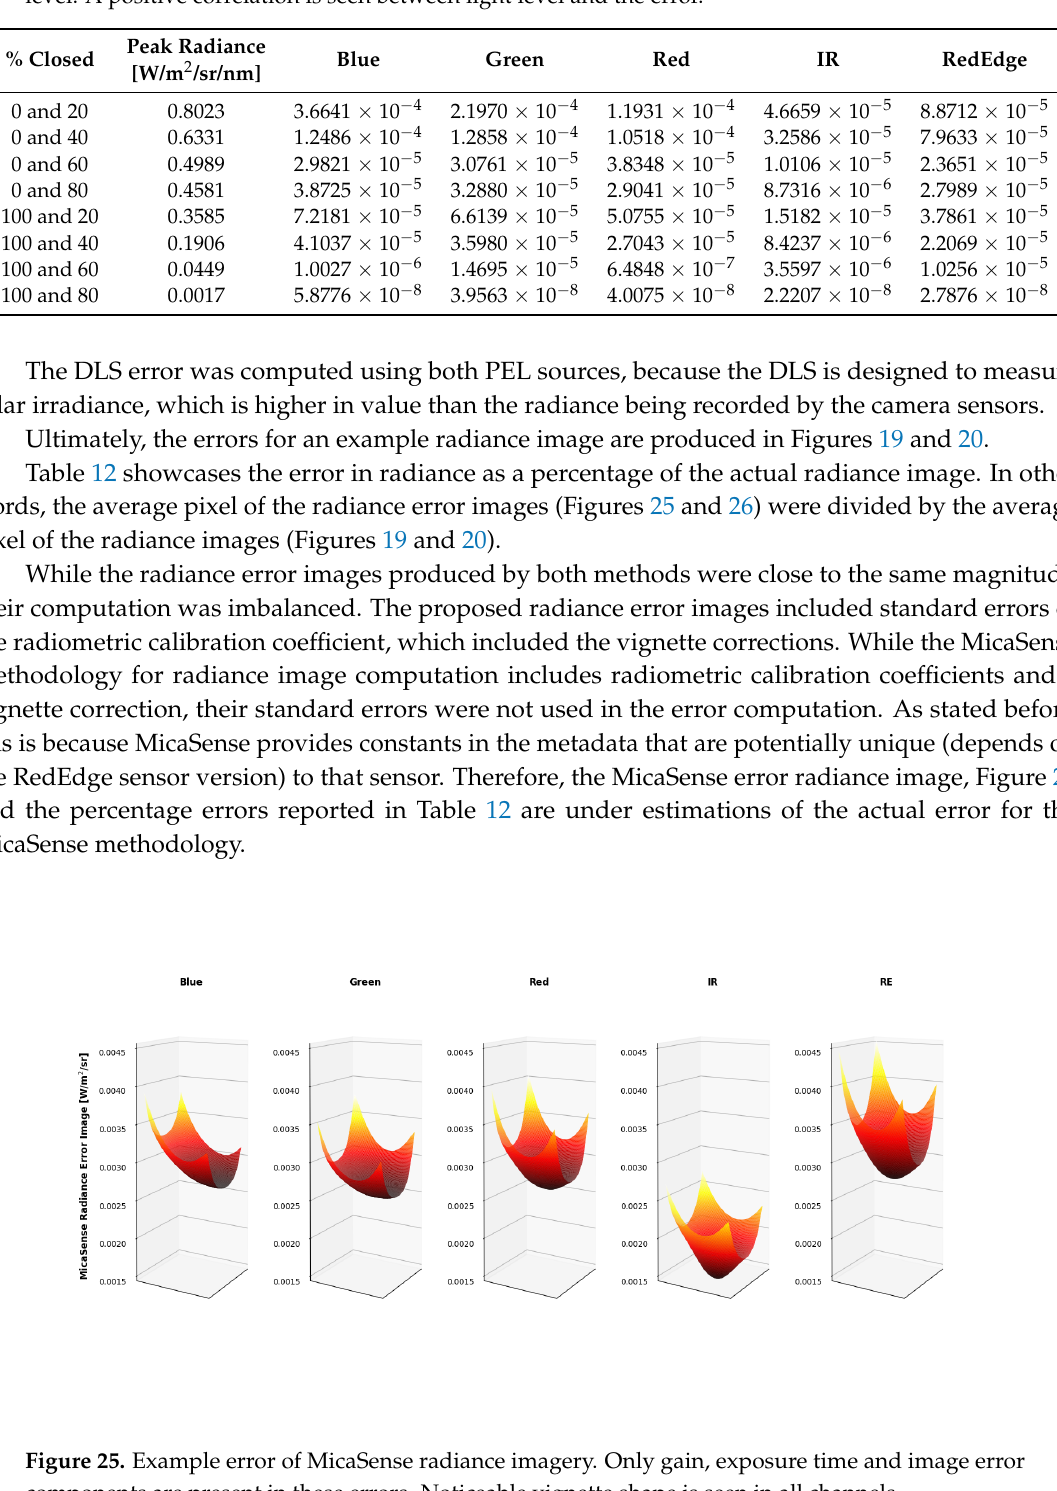
Table 11. RedEdge-3 downwelling light sensor (DLS) standard errors. DLS measurements made using an integrating sphere at various light levels. Standard errors computed from 30 images at each light level. A positive correlation is seen between light level and the error.